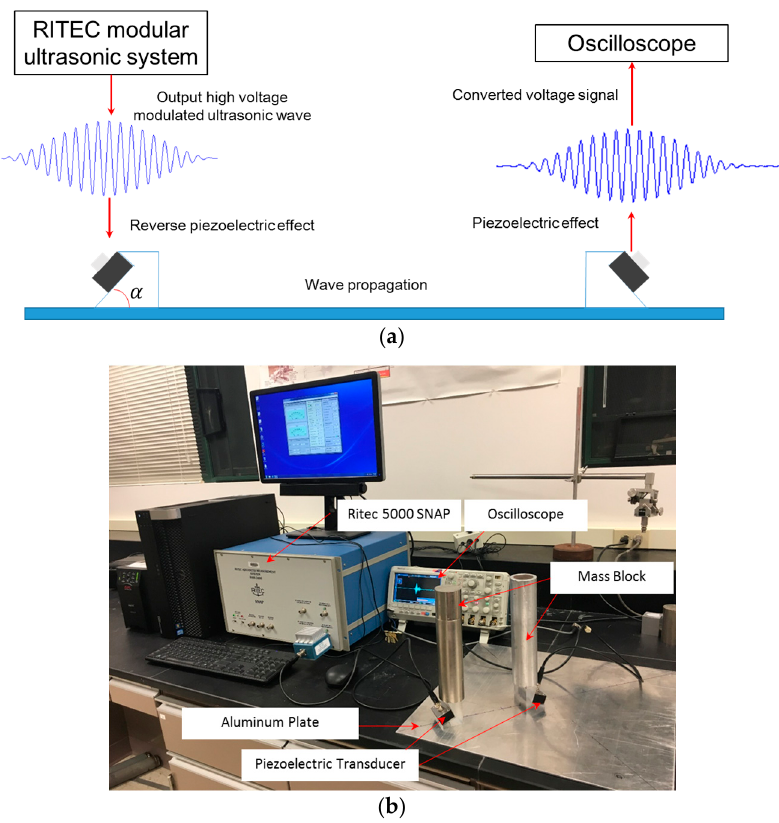
Figure 9. ( a ) Schematic of the experimental setup for the S 0 -S 0 and S 1 -S 2 mode pairs; and ( b ) photographic illustration of the